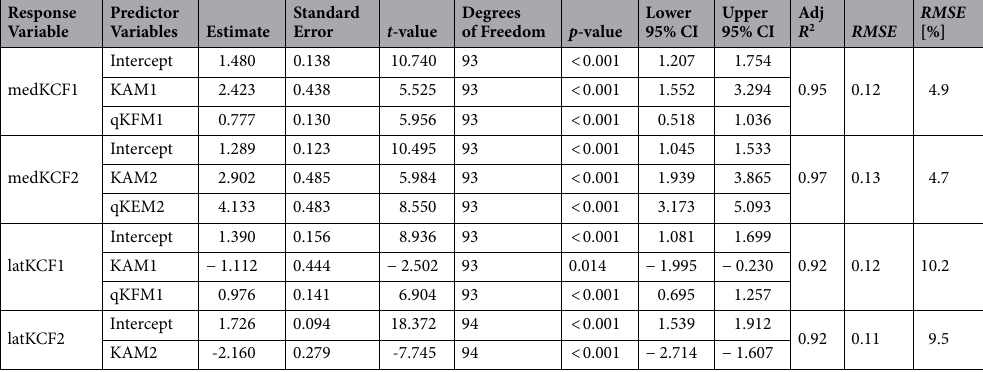
Table 3. Statistical summary of the linear mixed-effects models between the internal knee joint contact forces and external knee joint moments for the typically developed healthy control group. CI: Confidence interval; Adj. R 2 : adjusted R 2 ; RMSE : root mean squared error [BW]; medKCF1/medKCF2: max. value in the first/ second half of stance of the medial knee joint contact force [BW]; latKCF1/latKCF2: max. value in the first/ second half of stance of the lateral knee joint contact force [BW]; KAM1/KAM2: max. value in the first/second half of stance of the external knee adduction moment [Nm/kg]; qKFM1/qKEM2: squared maximal/minimal value in the first/second half of stance of the external knee flexion/extension moment (KFM1, KEM2; [Nm/ kg]).